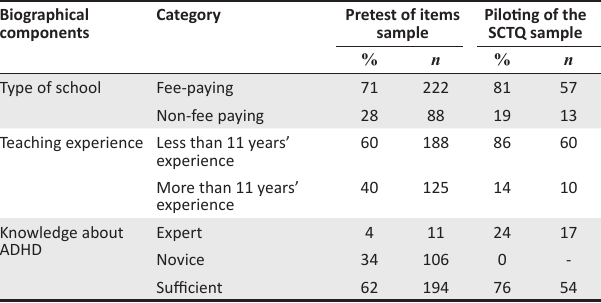
TABLE 3: Biographical profile of teacher